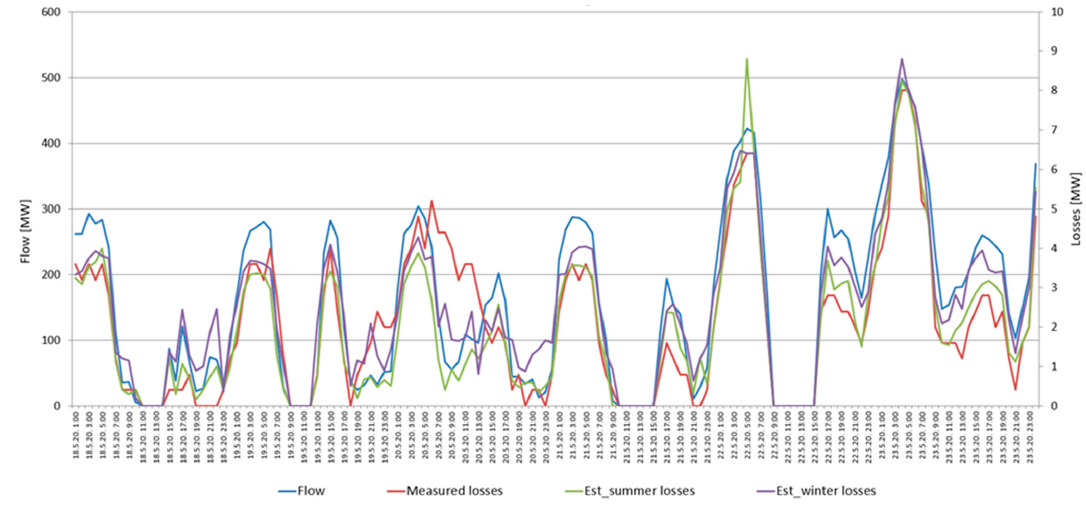
Figure 13. Actual load flow, measured losses, and estimation of losses on an hourly basis for the observed 400 kV OHL.